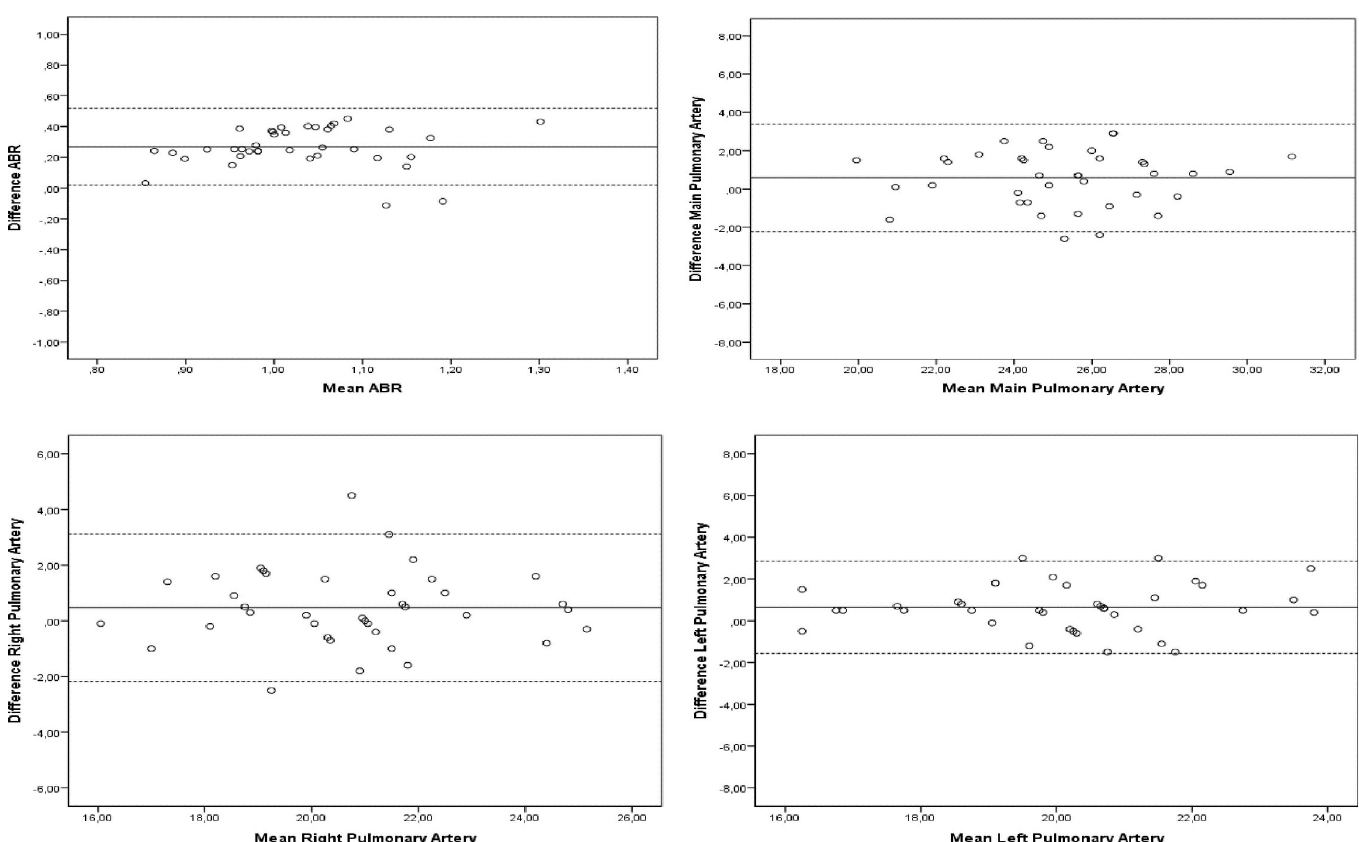
Fig 5. Interobserver limits of agreement. Interobserver limits of agreement with the Bland and Altmann technique.